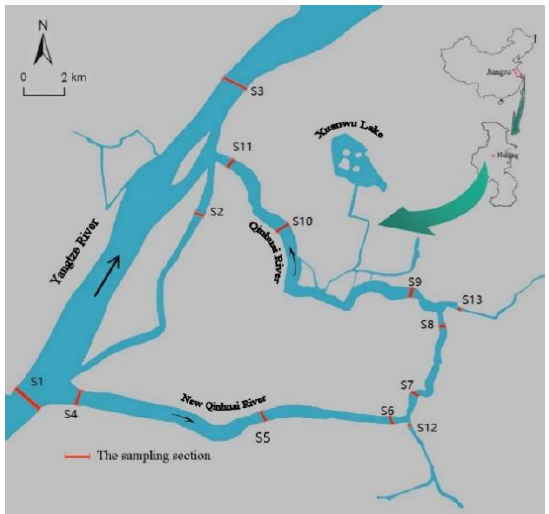
Figure 1. The locations of 13 sampling sites in the survey region from Nanjing, Jiangsu, China.